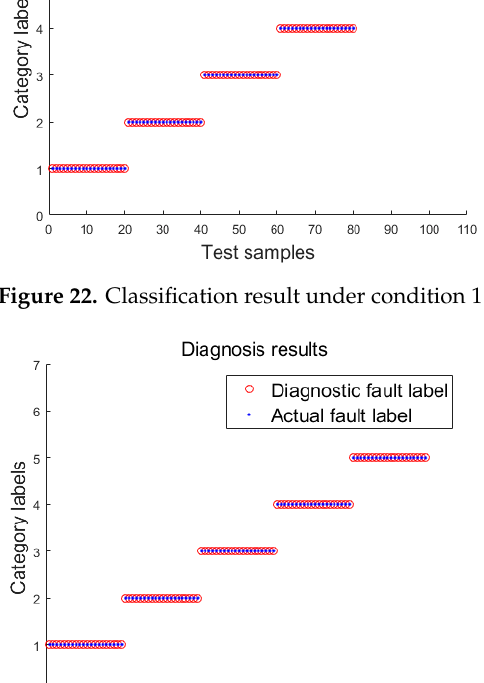
Figure 24. Classification result under condition 3.